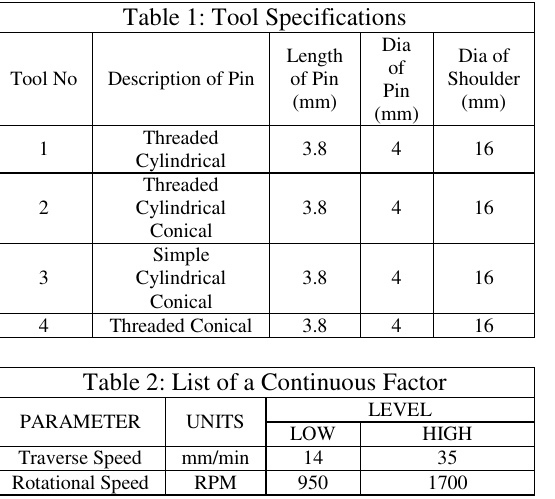
Table 1: Tool Specifications